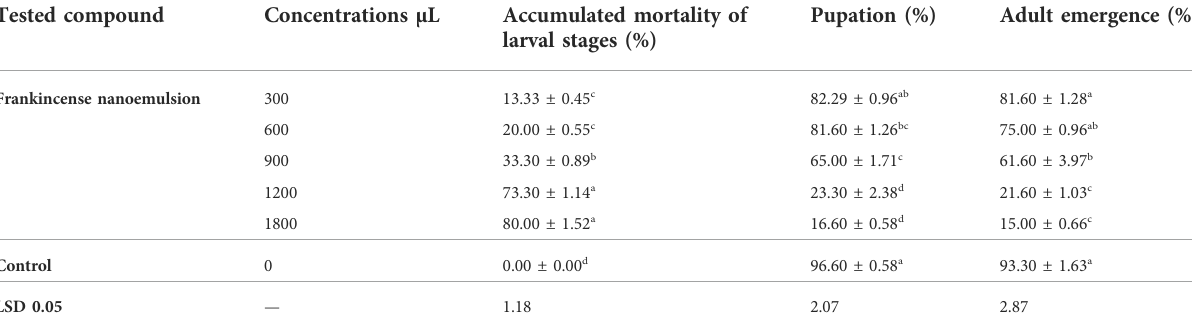
TABLE 2 Effect of formulated frankincense essential oil on larval mortality, pupation percentage, and adult emergence percentages of E. insulana . Tested